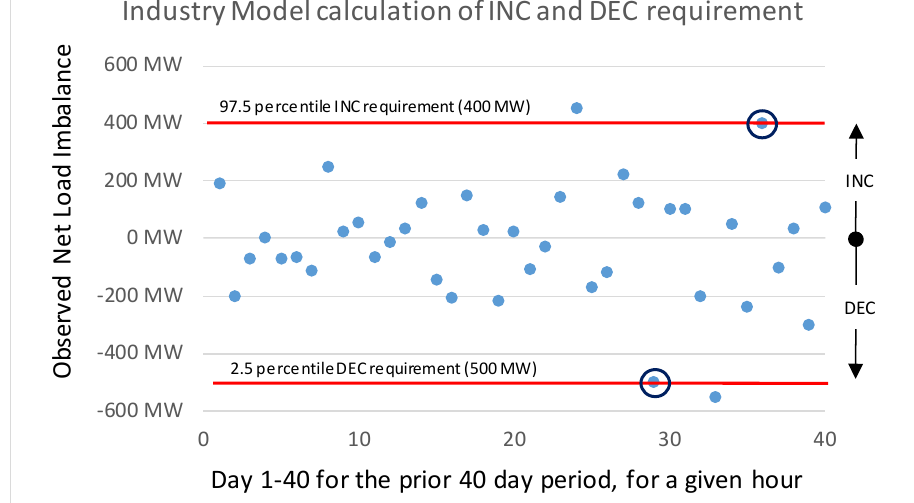
Figure 1. Industry Model calculation of INC and DEC requirement example.